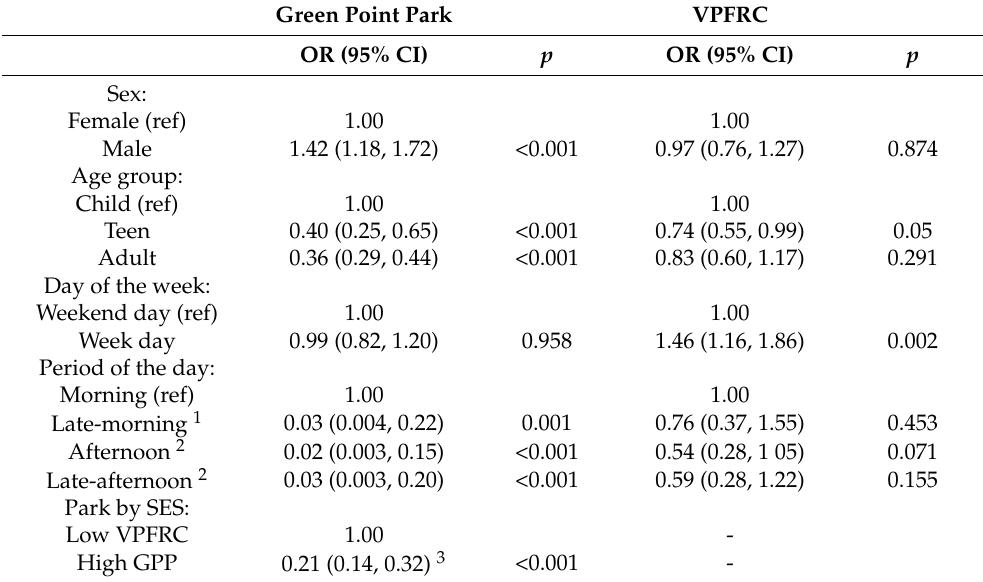
Table 7. Odds ratios for associations between observed park visitation characteristics and PA between Green Point Park and Valhalla Park Family Recreation